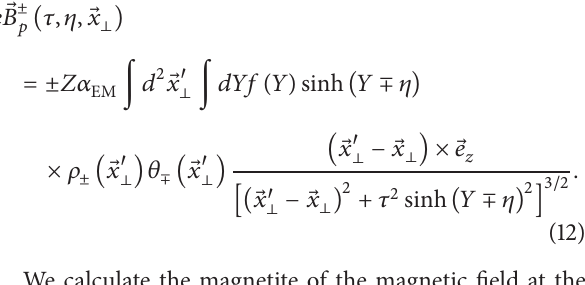
Experimental data shows that 𝑎 ≈ 1/2 , consistent with the baryon junction stopping mechanism. The contribution